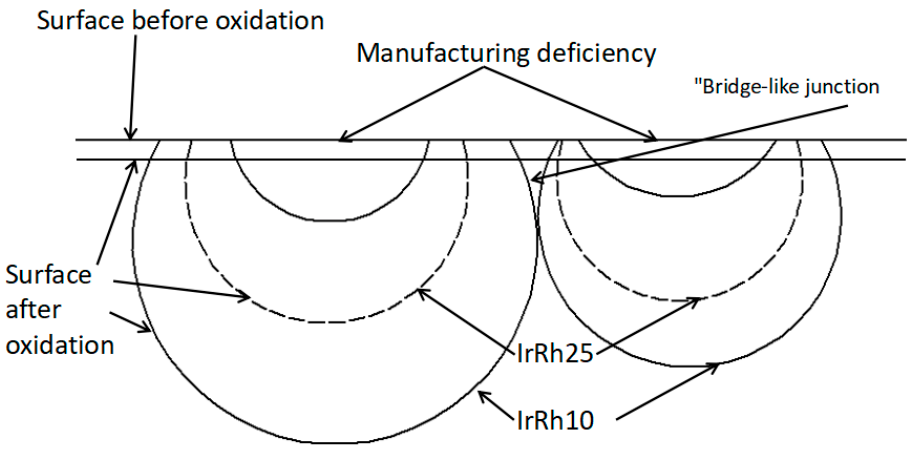
Figure 8. Schematic of oxidation-pit development.